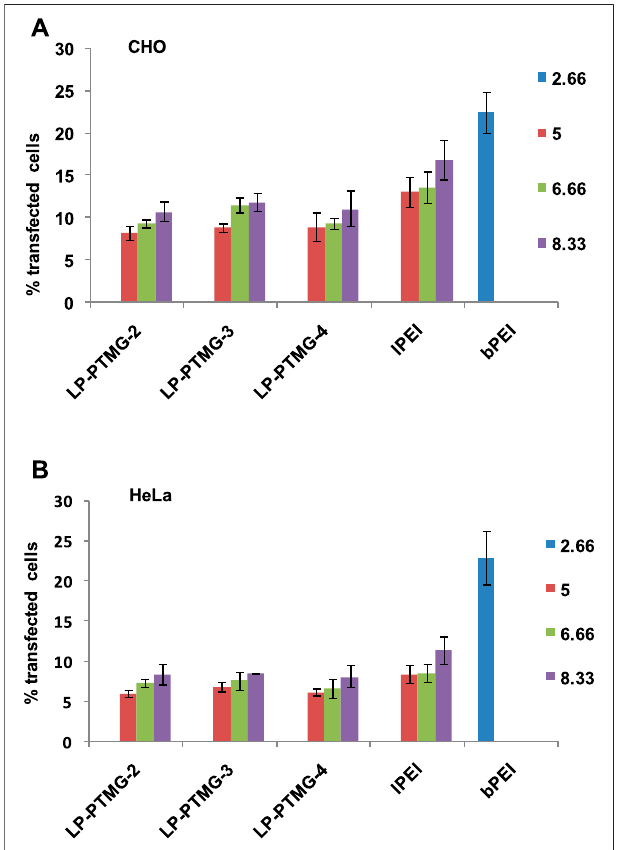
FIGURE 6 | Transfection ef fi ciency of LP-PTMG/pDNA, lPEI/pDNA and bPEI/pDNA complexes in (A) CHO, and (B) HeLa cells as determined by FACS analysis.